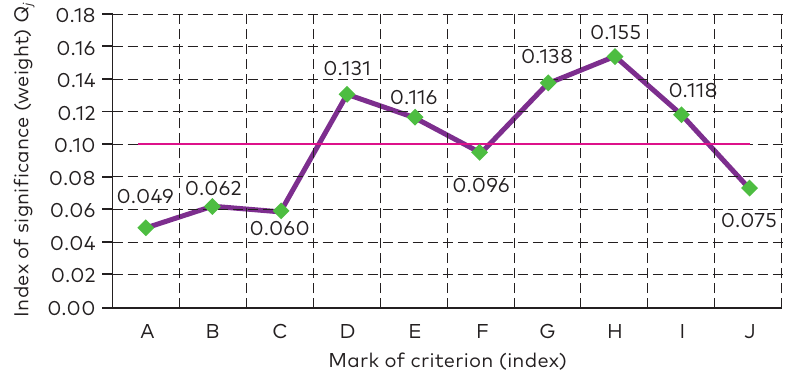
Figure 1. The values of the indices of significance (weight) Q criteria of the rest areas (compiled by the authors,